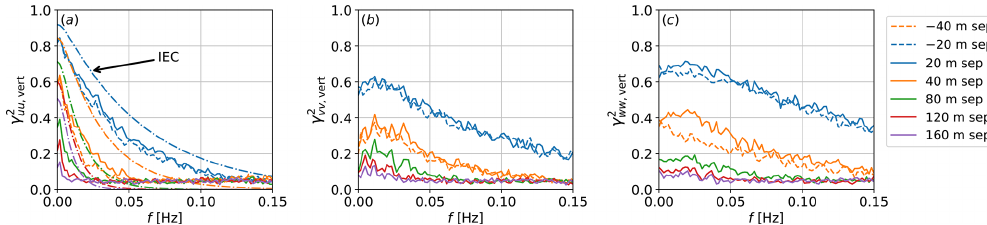
Figure 11. Coherence of the three turbulence components (a) u , (b) v , and (c) w separated vertically with respect to 80m. Negative separation means that one of the points is below 80m. Note the asymmetry shown by the same separation in different directions. Dash-dotted curves shown are obtained from the IEC-recommended Kaimal spectrum with the exponential-coherence model, where defined.